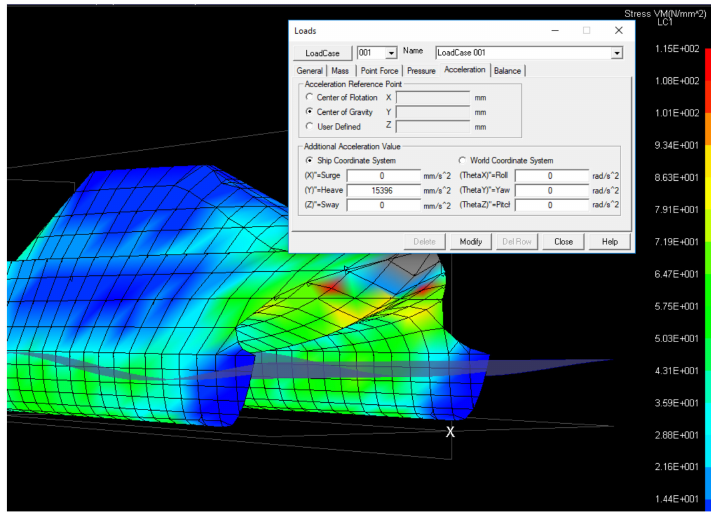
Figure 5. Additional acceleration applied due to the related sea state.